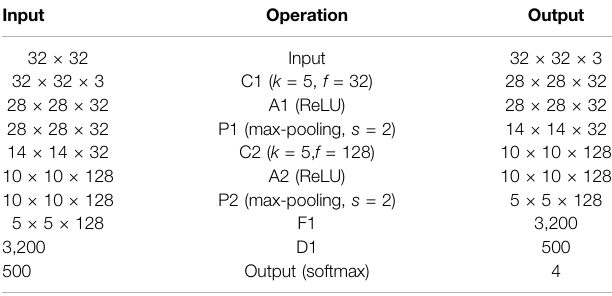
TABLE 1 | | Input, operation and output of CNN.